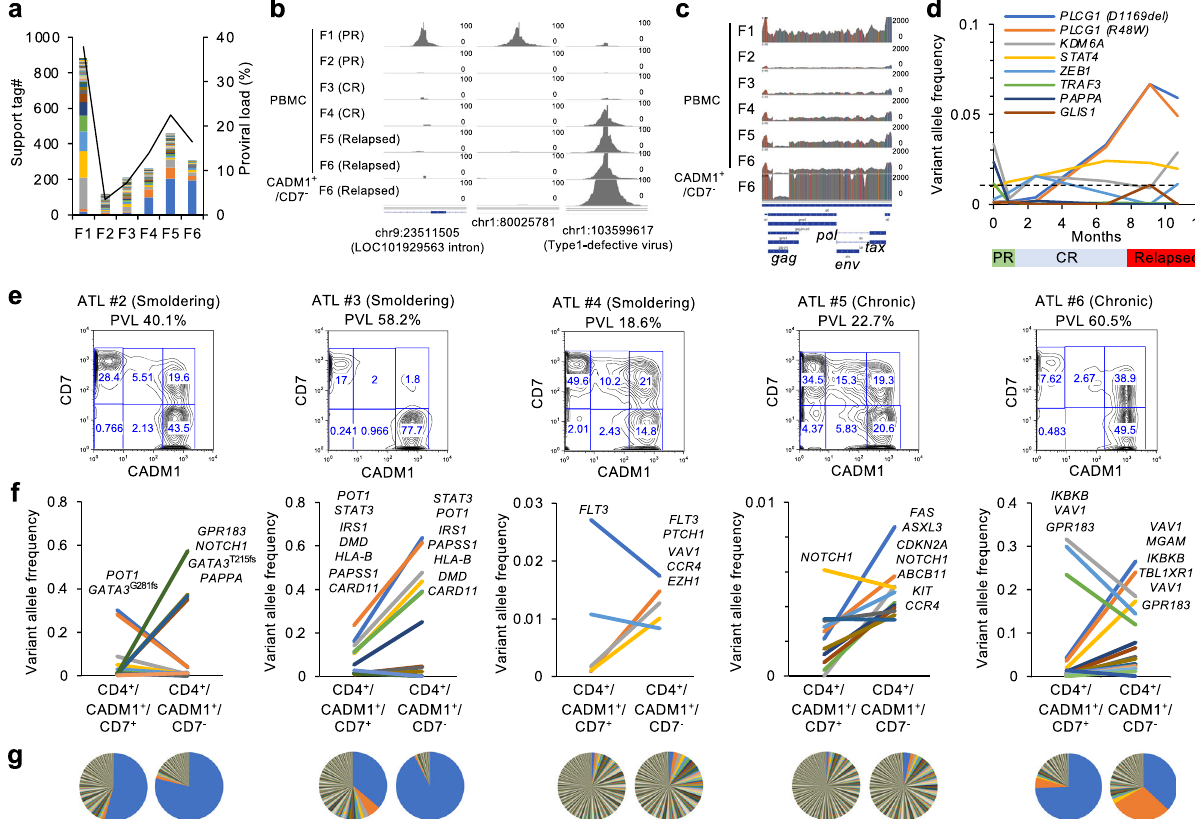
Fig. 3 Deep DNA sequencing of clinical specimens from ATL patients. a Stacked graph shows chronological transition of clone sizes calculated by VIS support tags in ATL#1. The black line represents HTLV-1 proviral loads (copy per 100 cells). b IGV images depict VIS reads called as initial dominant clones (Chr9:23511505, Chr1:80025781) and a relapsed clone (Chr1:103599617) in F1-F6 PBMC and F6 CADM1 + /CD7 − enriched subpopulation. c IGV images depict sequence reads mapped to whole HTLV-1 provirus in F1-F6 PBMC and F6 CADM1 + /CD7 − enriched subpopulation. d Line plot shows chronological transition of variant allele frequencies of somatic mutations at F1 to F6. e – g Panels provide results of deep panel sequencing in fi ve indolent ATL cases (ATL#2 – 6). HAS- fl ow plots show HTLV-1-infected subpopulation (CD4 + /CADM1 + /CD7 + , “ D ” ), more aggressive subpopulation (CD4 + /CADM1 + /CD7 − , “ N ” ), and HTLV-1-uninfected T cells (CD4 + /CADM1 − /CD7 + , “ P ” ) ( e ). Line charts show VAF values in D and N with annotations of major mutated genes ( f ). Pie charts represent clonalities based on VIS reads in each D (left) and N (right) subpopulations ( g